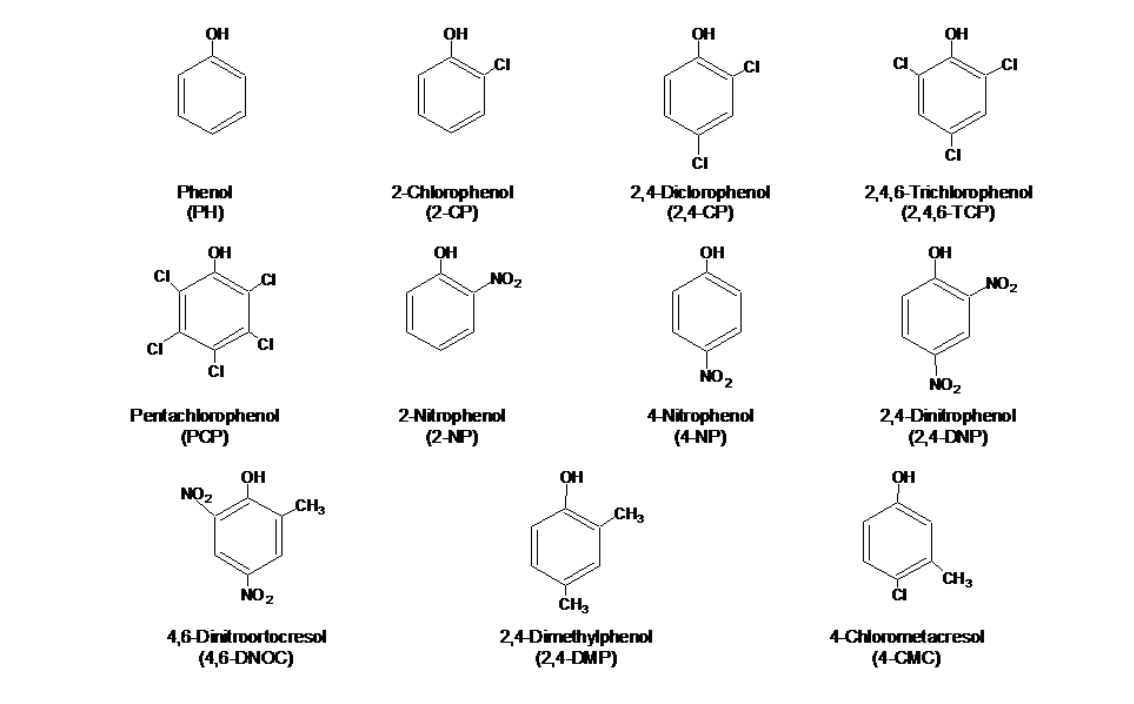
Figure 1 . Structures of eleven phenolic compounds considered priority pollutants by US